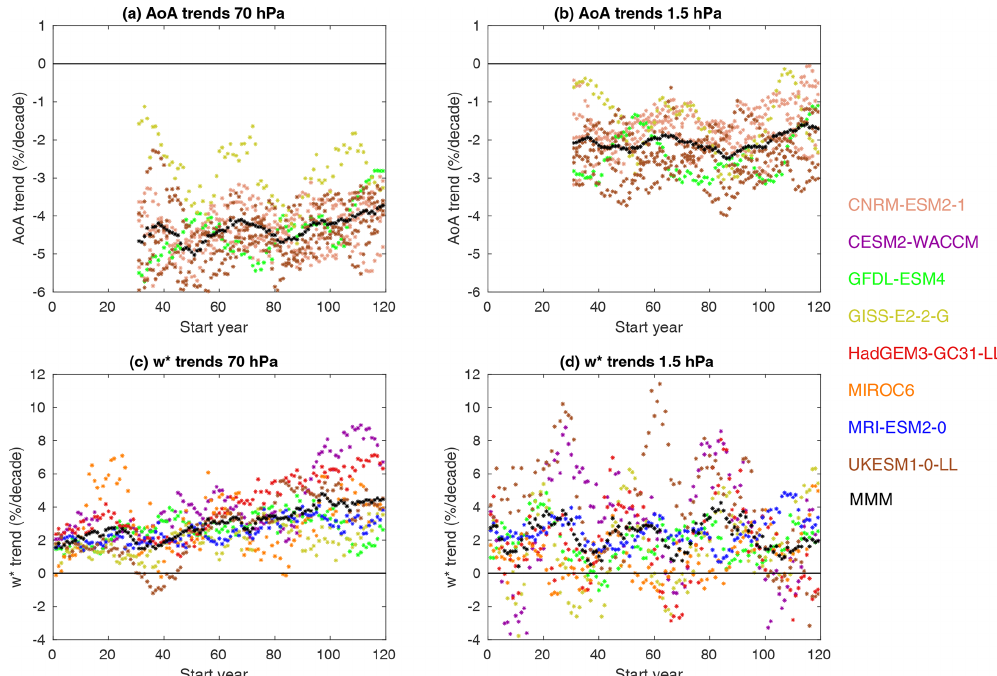
Figure 10. Trends in AoA (a, b) and upwelling (c, d) at 70hPa (a, c) and 1.5hPa (b, d) calculated from 30-year slices of the 1pctCO2 simulations with start year indicated on the x axis, for each individual simulation (dots; see legend for colors) and the MMM trend (black). AoA is averaged over 45 ◦ S–45 ◦ N and tropical upwelling is averaged between turnaround latitudes. Note that for upwelling only one member is included, but for AoA all available members are included, in order to have a more comparable total number of simulations for both variables. The number of available members is 4 for CNRM-ESM2-1, 1 for GFDL-ESM4, 1 for GISS-E2-2-G, and 4 for UKESM1-0-